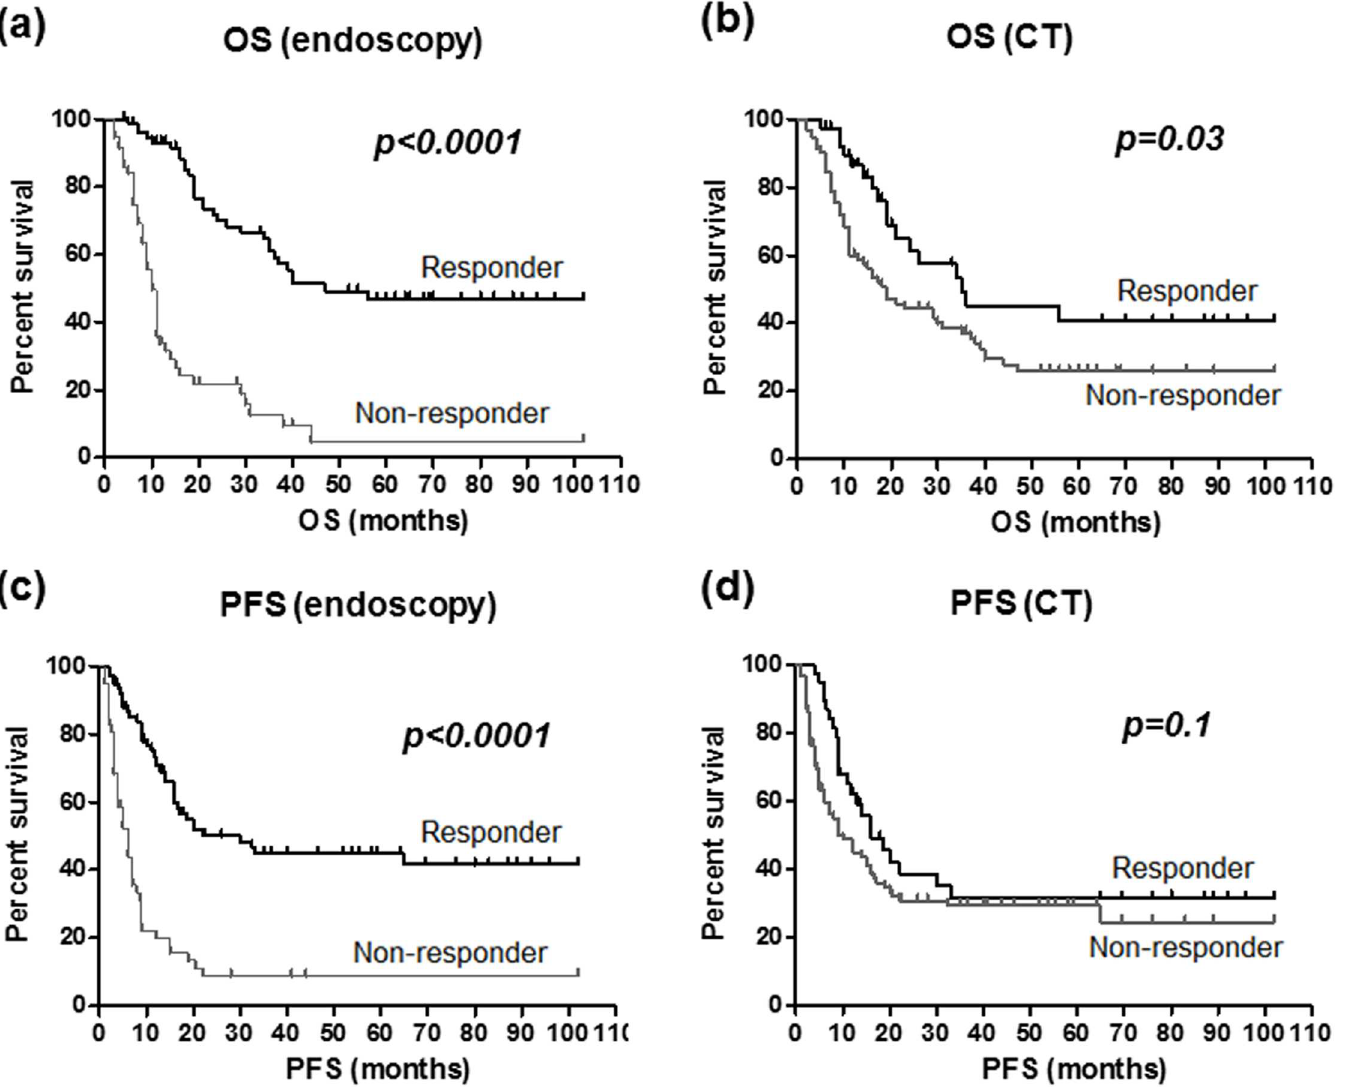
Fig 4. Overall survival (OS, upper) and progression-free survival (PFS, lower) and endoscopy (left) and CT (right) based response evaluations in caseswho receivedS1 plus CDDP. Different two groups was assessedusing the Kaplan-Meier method and the Log rank test.